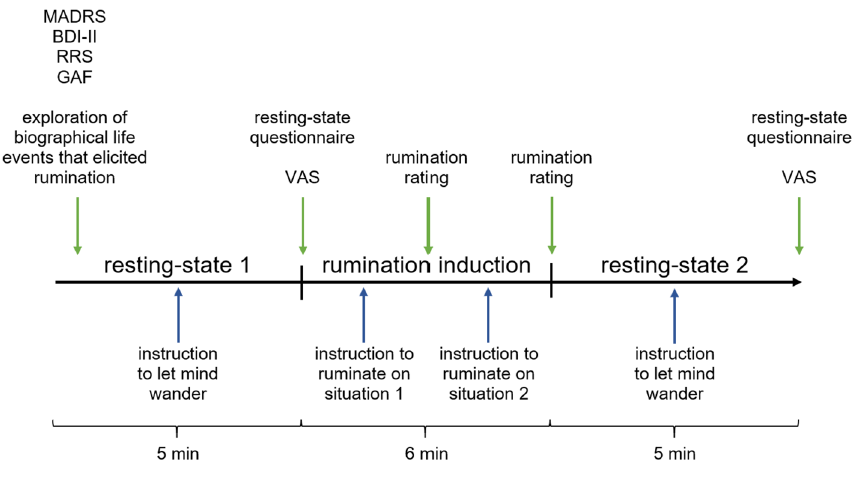
Figure 1. Time course of the conducted